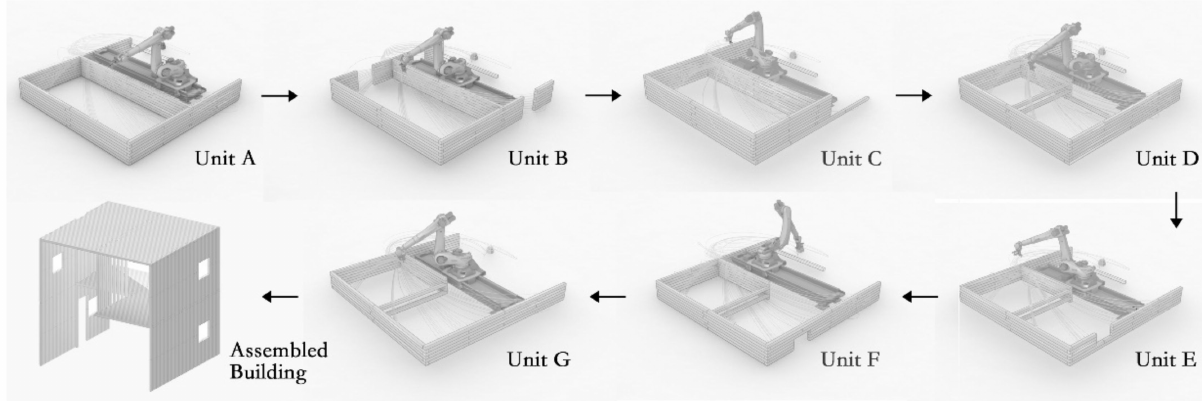
Figure 8. Snapshots of the entire building with seven units built by the